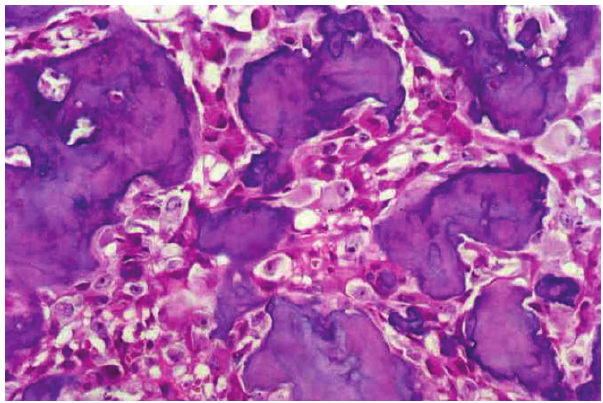
Figure 3 - Atypical osteoblastoma. Epithelioid osteoblasts with eosinophilic cytoplasm and large vesicular nuclei with prominent nucleoli (Case 28, hematoxylin-eosin stain, X